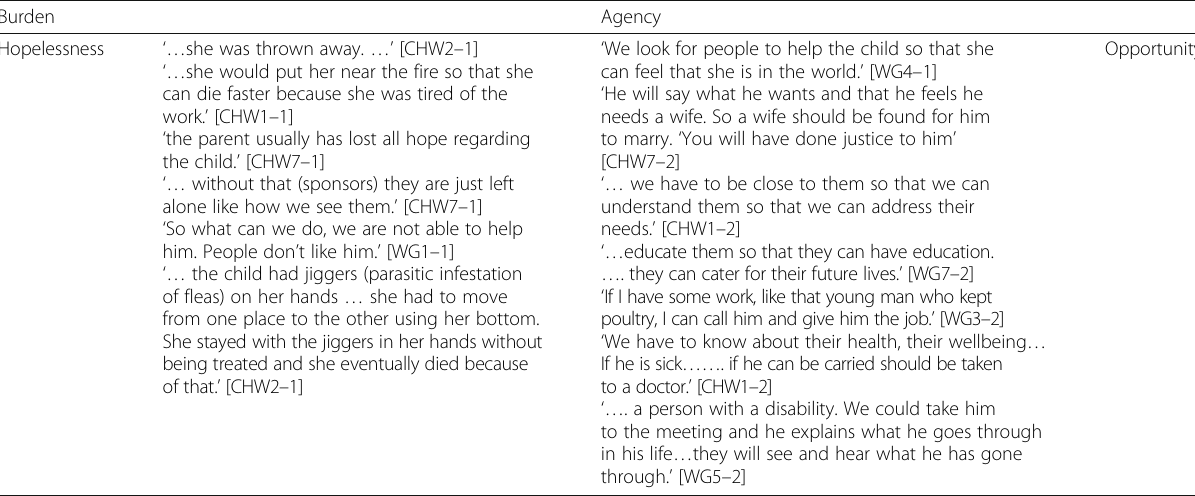
Table 3 Burden vs Agency construct: Hopelessness-Opportunity